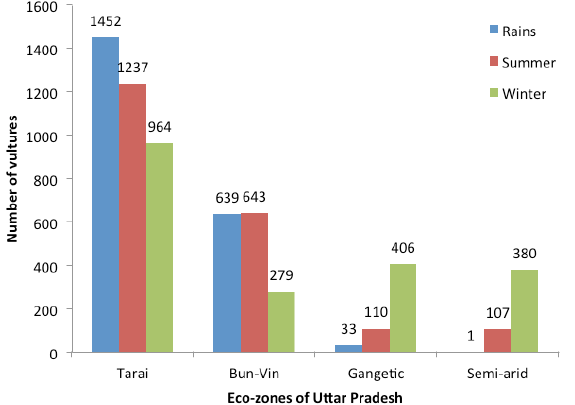
Figure 4. Distribution of vulture population in three different seasons of 2010–2011 in different eco-zones (Bun-Vin = Bundelkhand-Vindhyan eco-zone)